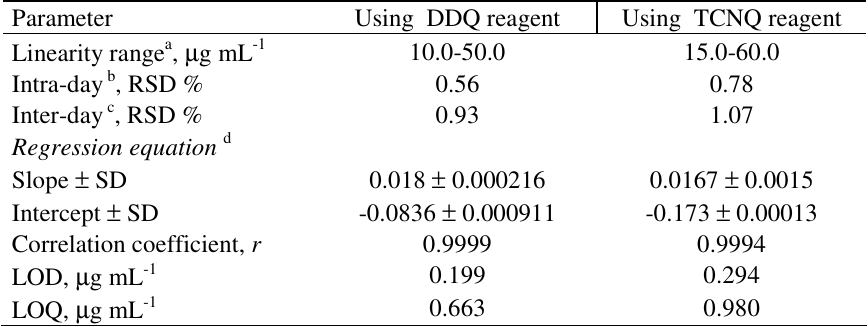
Table 1. Results of validation parameters for proposed